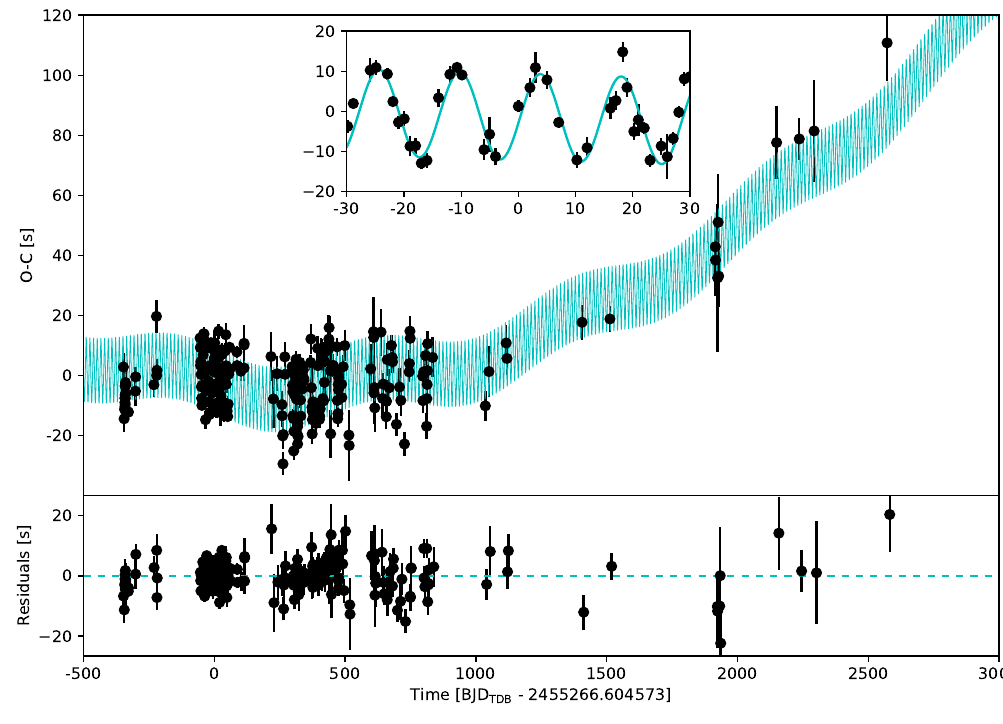
Figure 2. The O-C diagram of CS 1246, constructed from its 371.7 s pulsation mode. Three major patterns dominate the diagram: (i) a concave-up parabola, indicating a period increase, (ii) a short–period sine wave from reflex motion due to the previously–confirmed M dwarf companion, and (iii) a long-period sine wave, consistent with reflex motion of the entire inner sdB+dM binary, possibly due to a cir- cumbinary planet. The solid lines denotes our best–fitting model to the data (Equation 2). The inset highlights the strong 14.1-d oscillation from the M dwarf companion. The bottom panel shows residuals of the data and the nonlinear fit (Eq. 2).